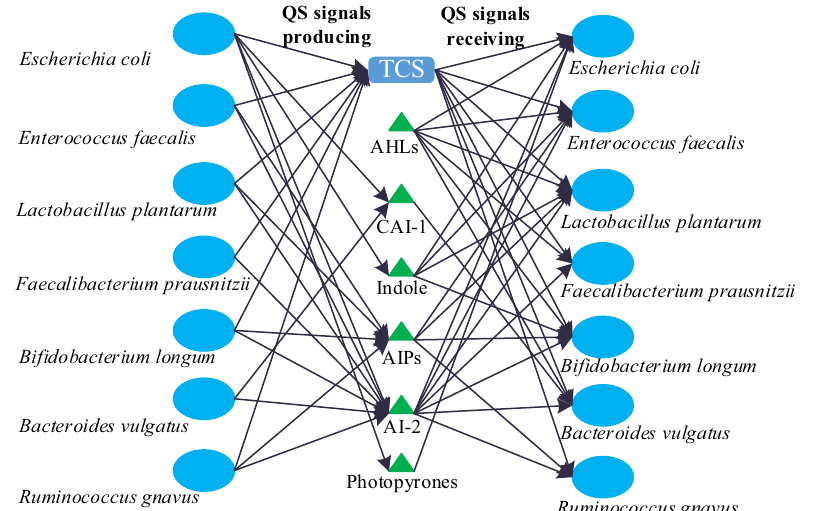
Fig. 6 Typical small QSCN that includes QS signals producing and receiving for seven human microbes. Note that the seven-strain simpli fi ed human microbiomes are taken from Colosimo et al. 42